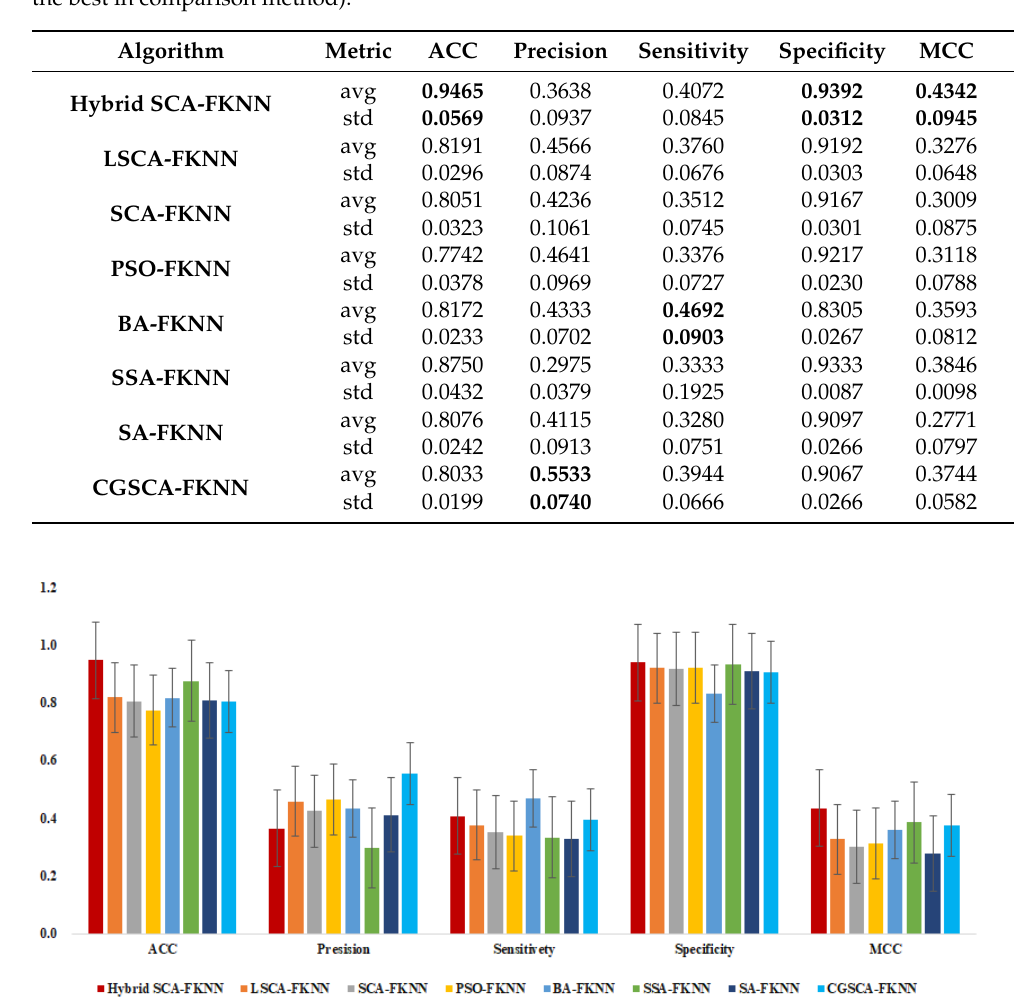
Figure 6. Classification performance of each model on the hepatitis